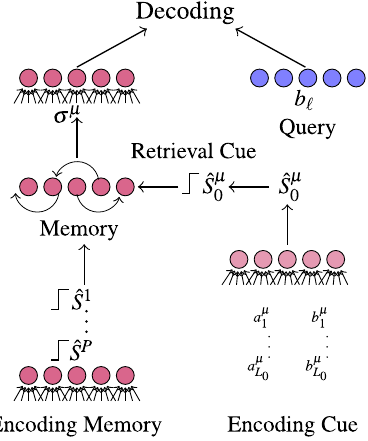
Figure 2. A schematic of the process of storing multiple binarized structures in a memory network. These structures can be retrieved from memory by encoding a retrieval cue from a subset of the relations in the desired structure as in Eq. (6) and initializing the network in the state of the binarized